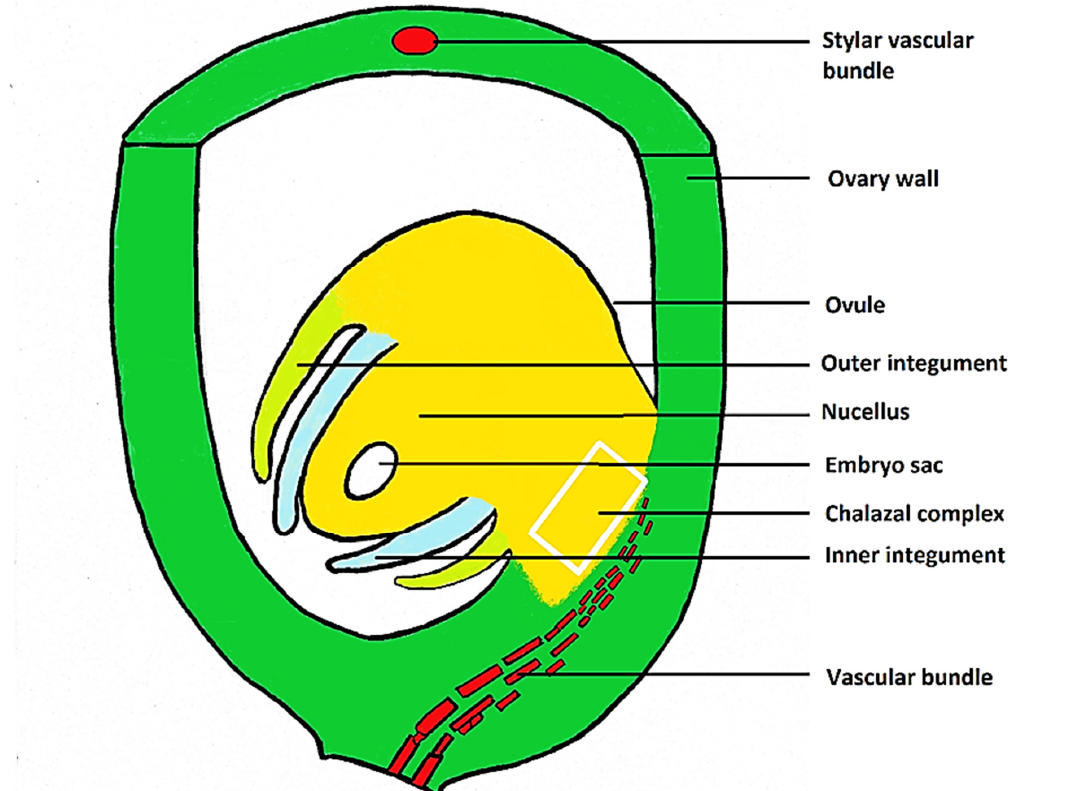
Figure 2 Diagrammatic representation of a pre-anthesis ovary showing its organs and tissues. The ovular vascular trace from the pedicel ends at the base of the